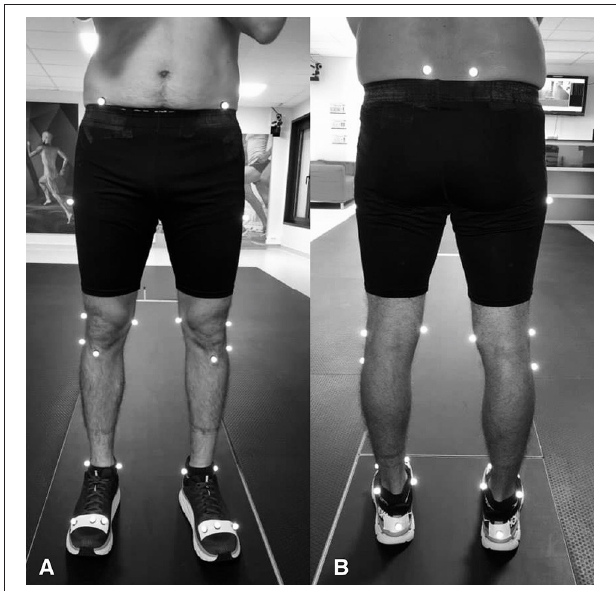
FIGURE 1 | Istituti Ortopedici Rizzoli (IOR) lower body marker set—anterior (A) and posterior (B) views ( Leardini et al.,